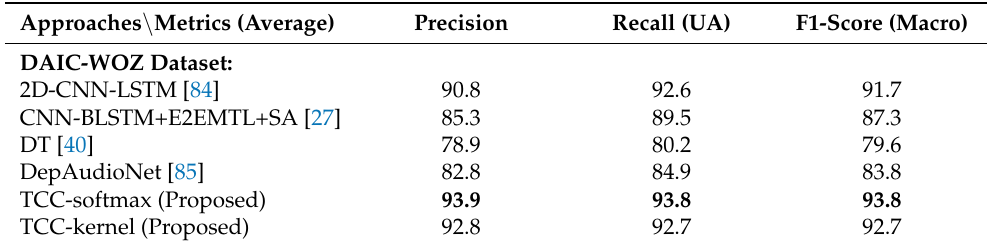
Table 3. The (unweighted) average precisions, recalls (UA), and F1-scores (macro) (%) of the proposed TCC approach (including ‘softmax’ and ‘kernel’ setups) and the state-of-the-art approaches (2D-CNN- LSTM, CNN-BLSTM+E2EMTL+SA, DT, and DepAudioNet) on the DAIC-WOZ dataset. Approaches \ Metrics